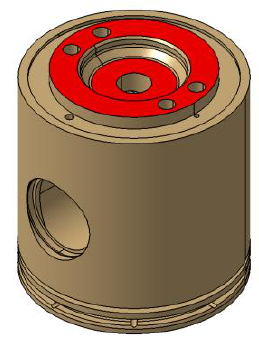
Fig. 5. Contact surface of two different materials As boundary conditions, heat transfer coefficient map on the piston crown taken from CFD combustion model and constant piston crown temperature 850 K were assumed [3].